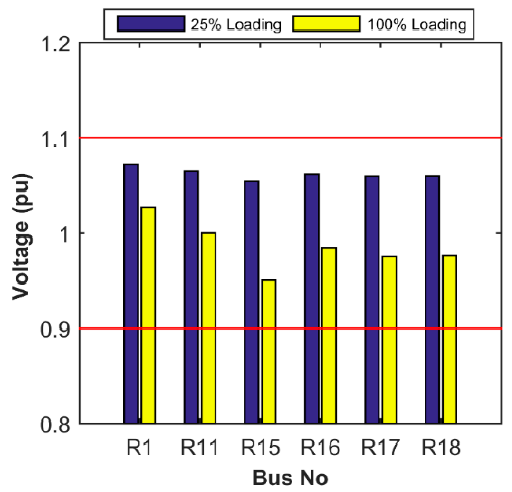
Figure 4 . Bus voltage magnitudes for minimum and maximum loading conditions with no PV. Figure 4. Bus voltage magnitudes for minimum and maximum loading conditions with no